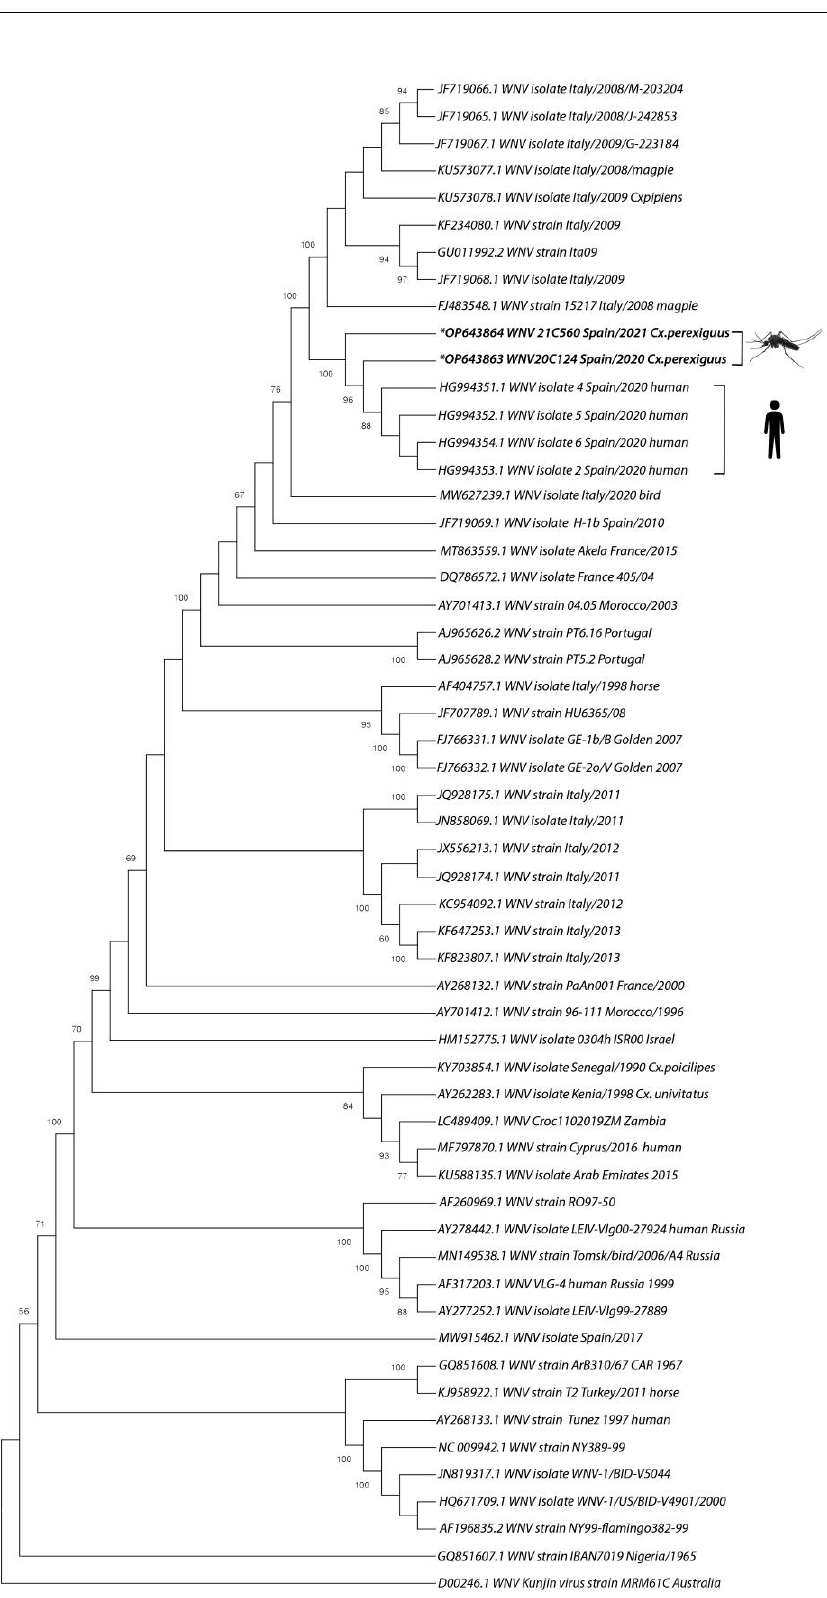
Figure 2. Phylogenetic analysis of polyprotein nucleotide sequences of WNV-L1. The tree was constructed using a maximum likelihood method. Bootstrap values are given for 1000 replicates. Viral sequences are identified by the GenBank accession number, country and year of isolation.